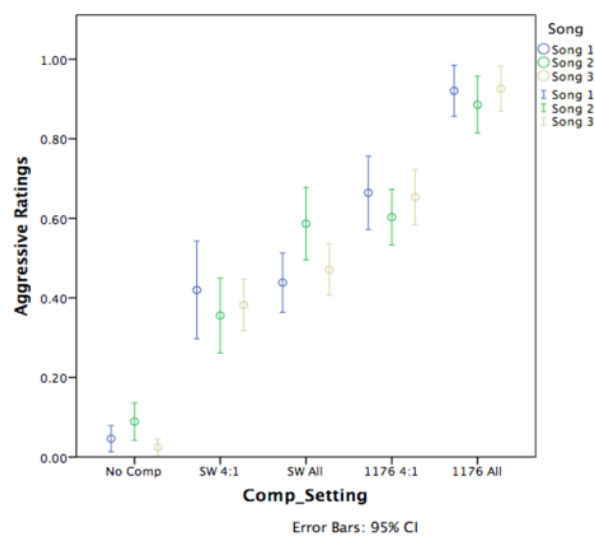
Figure 6. Aggressive results from the second listening experiment.